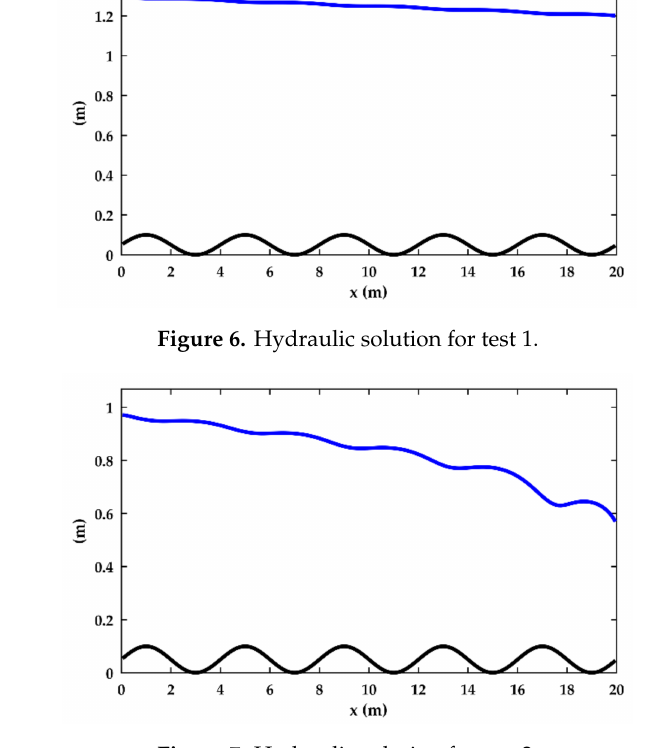
Figure 7. Hydraulic solution for test